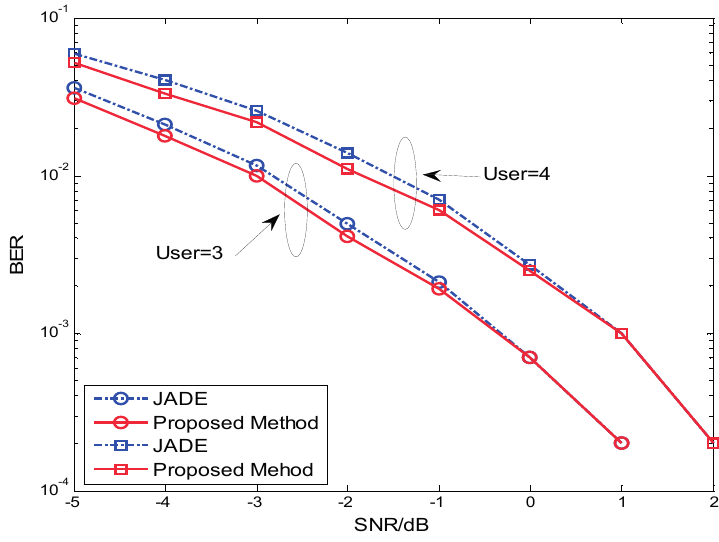
Figure 3. BER performance comparison between JADE and the proposed method for user separation in DS-CDMA